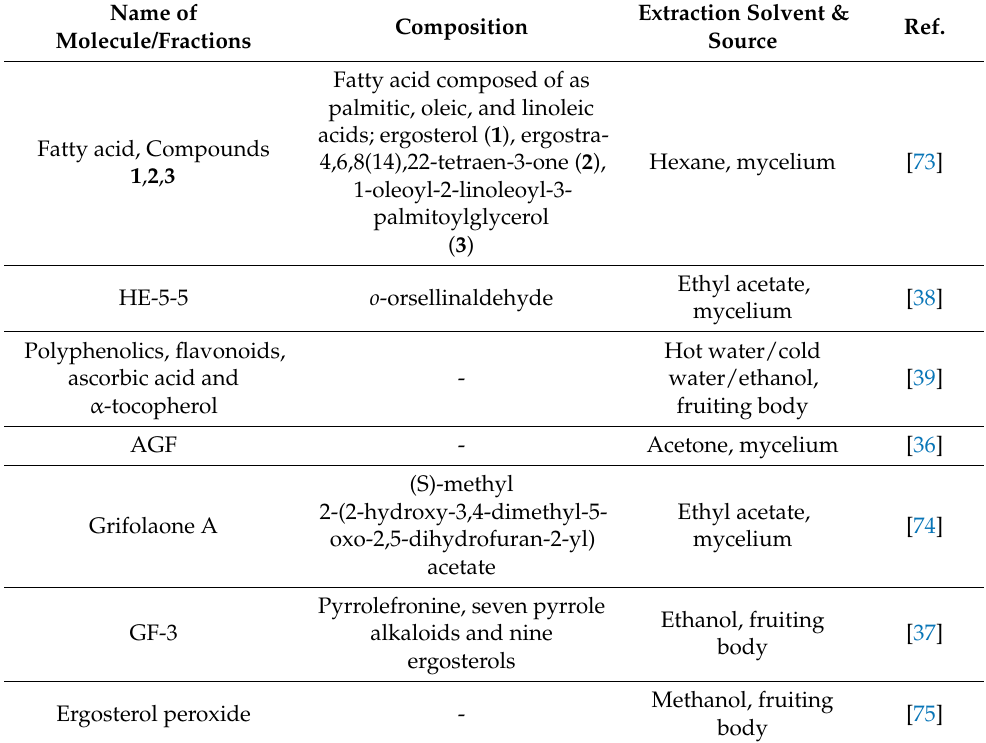
Table 6. Bioactive small molecules isolated from G. frondosa . Name